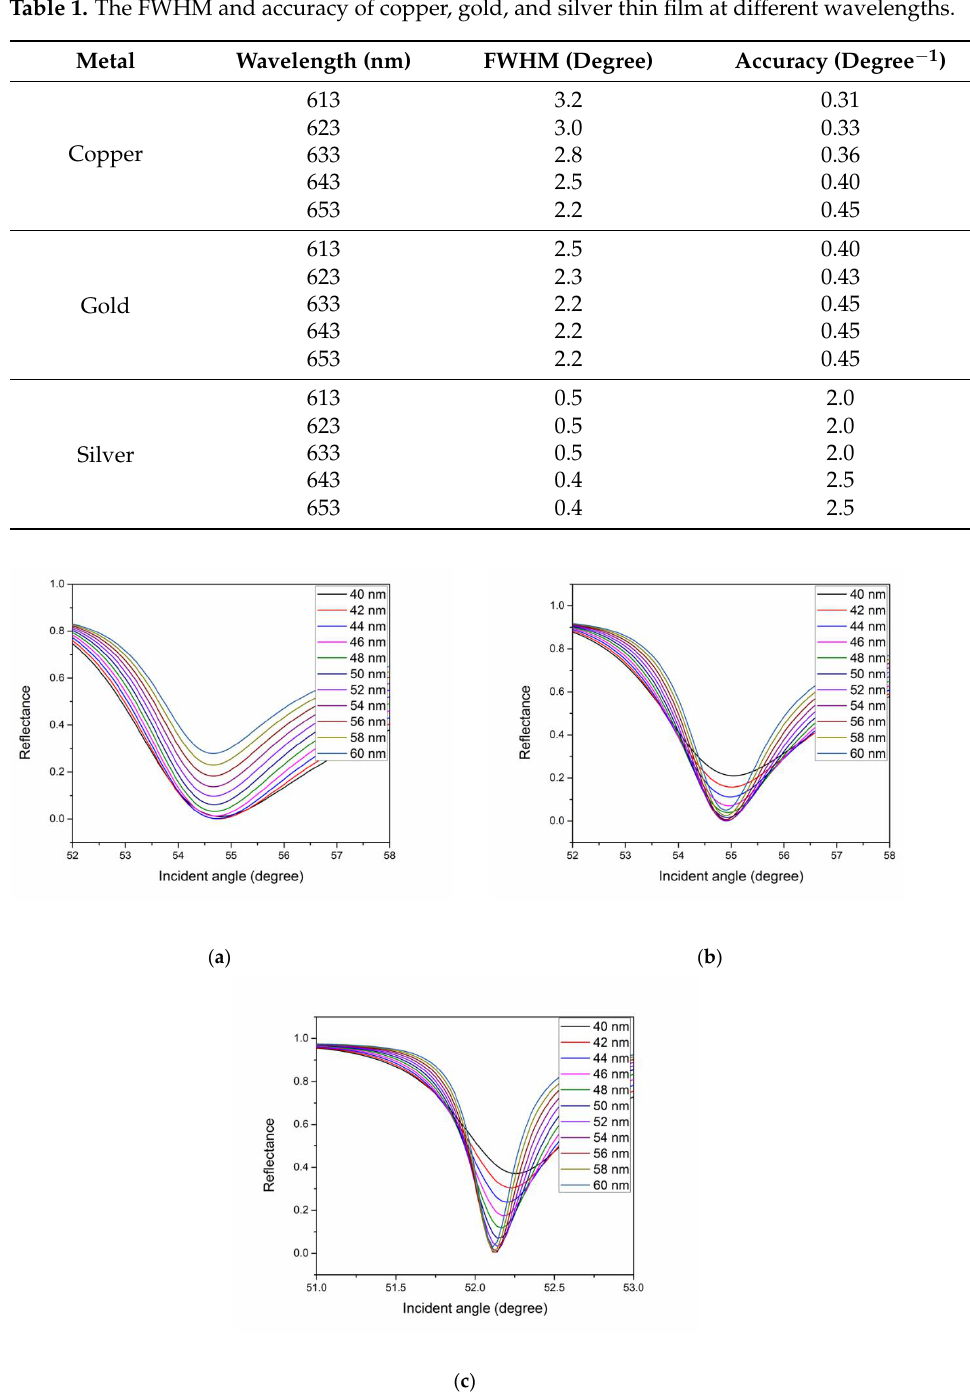
Figure 8. Optimization of the SPR signal based on different thickness of ( a ) copper, ( b ) gold, and ( c ) silver in contact with water and excitation wavelength of 633 nm. From the simulation results, the red light of 633 nm wavelength has been proven to be the most appropriate light source to generate SPR. For metal selection, copper is not favorable to generate SPR owing to its optical properties that give a higher reflectance minimum and high FWHM value of the reflectance curve, hence decreasing the accuracy of the SPR in sensing application. The SPR signal is the best for both gold and silver thin films. However, silver has poor chemical stability and less inert compared to the gold that limits its application. Therefore, the most favorable metal to generate SPR is gold that gives a low reflectance minimum and smaller width of the reflectance curve [77]. Besides that, gold is also inert and has higher chemical stability that gives advantages for wider application. 4.2. Analysis of Thin Films Properties Gold thin film has been used to generate SPR using water as the dielectric medium at room temperature. The experimental SPR signal then was fitted to obtain the infor- mation on the thin film properties as shown in Figure 9. According to the fitted SPR signal, the optical properties of the prepared gold thin film for the real part, n and imaginary